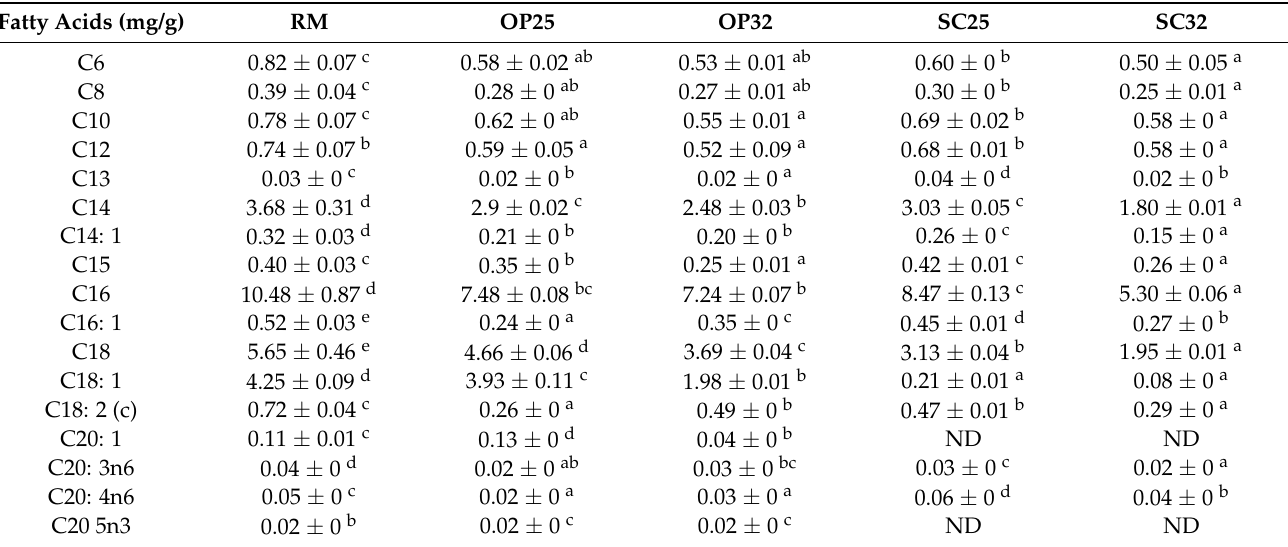
Table 5. Fatty acid composition of raw milk and